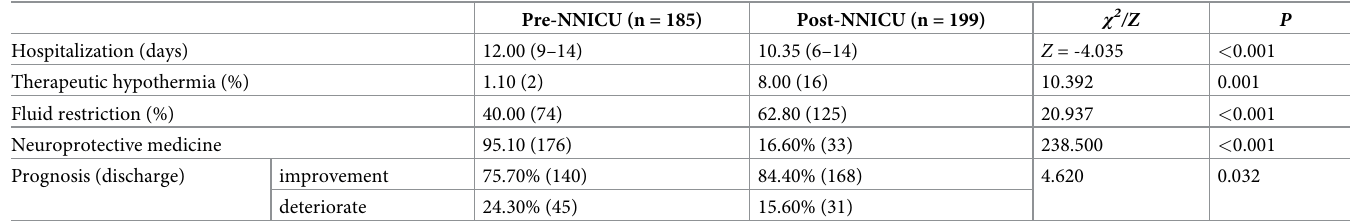
Table 4. Neuroprotective therapy of the neonates.